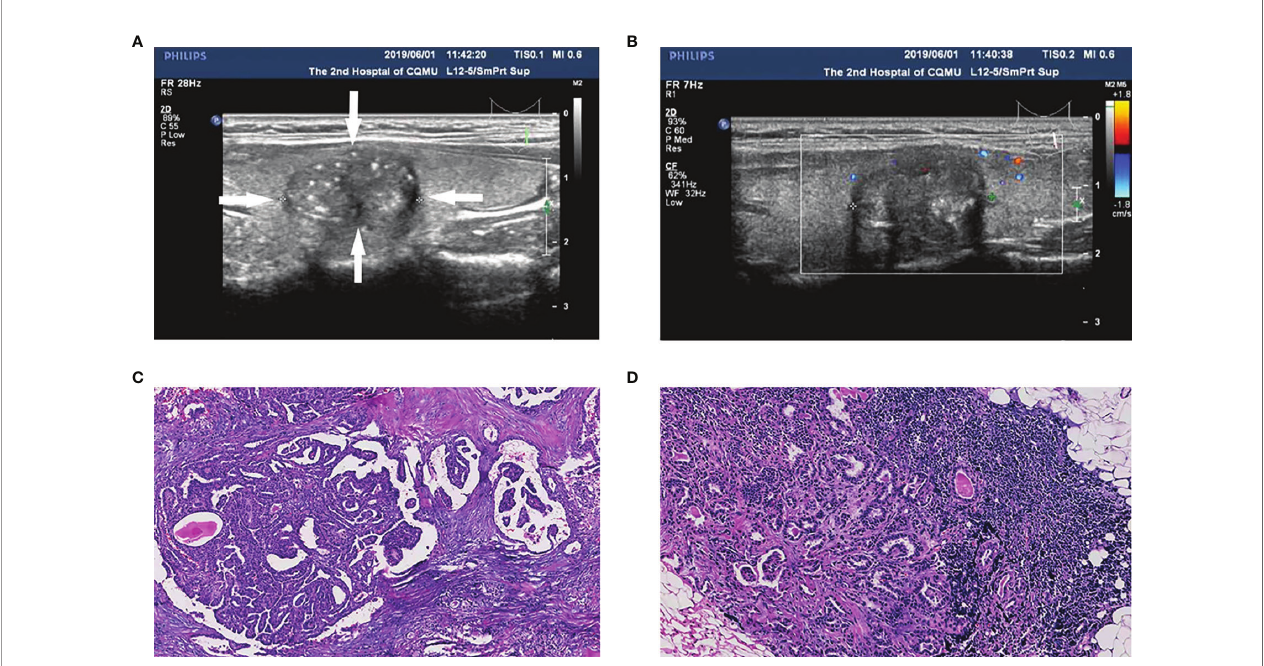
FIGURE 2 | A papillary thyroid carcinoma (PTC) patient (35-year-old male, 1.5 cm nodule) with central cervical lymph node metastasis (CLNM) and positive BRAF V600E mutation. (A) The thyroid nodule had a low echo, microcalci fi cations, and irregular morphology on US images. (B) Color doppler fl ow image (CDFI) showed a lack of blood supply inside the nodule. (C) Pathologic examination con fi rmed the diagnosis of PTC. (D) Pathologic examination con fi rmed the diagnosis of central CLNM.